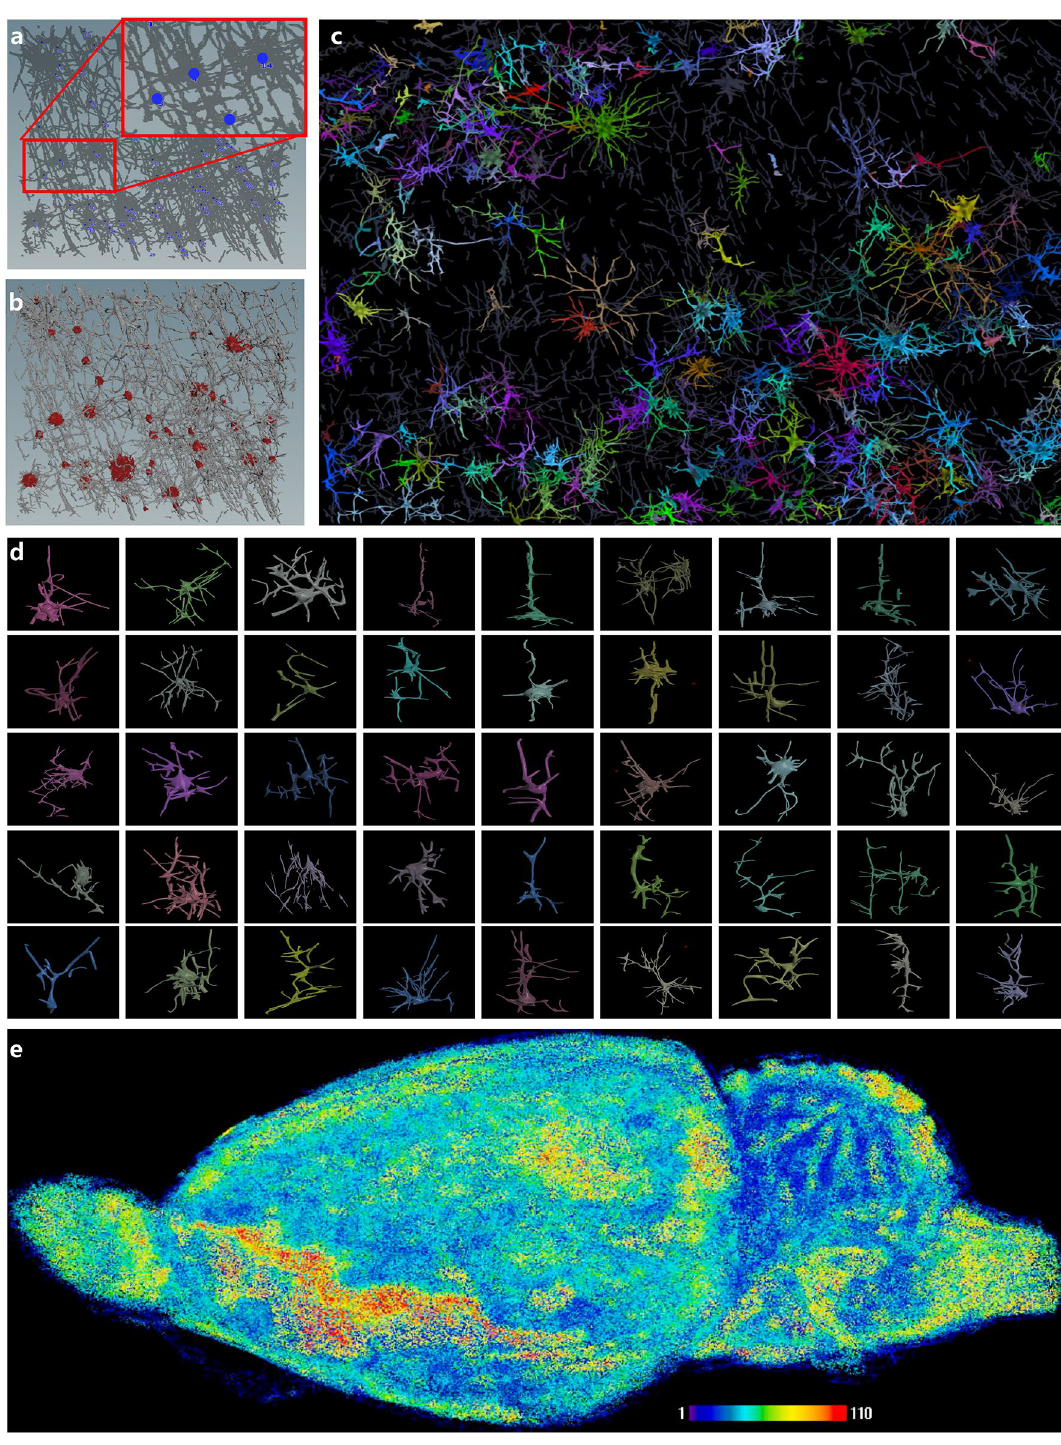
Figure 3. The self-reconstructed 2.6 million rat cells without labels. ( a ) Neuron branch detection and reconstruction. ( b ) Neuron soma identification and surface detection. ( c ) Different types of neurons were reconstructed from the neocortex; different colors represent different types of neurons. ( d ) The reconstructed CASIA rat-neuron dataset with approximately 2.6 million cells from a single rat brain. ( e ) The density of neurons in the whole rat